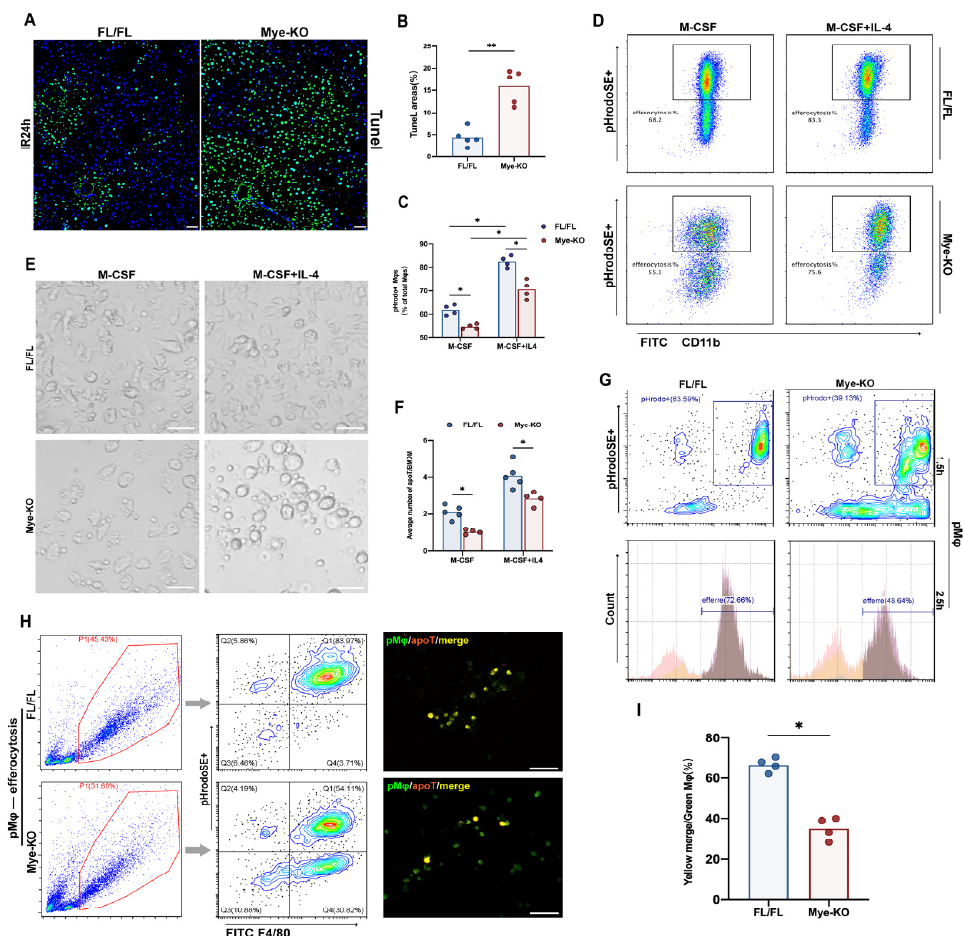
Figure 5. Myeloid Trem2-controlled efferocytosis promotes the resolution of IR inflammation. ( A ) Tunel staining was used to determine the number of apoptotic cells in the IR24h liver of Trem2 FL/FL or Trem2 mKO , scale bars=50 μ m; ( B ) Qualification of Tunel staining ( ** p < 0.01 ) ; ( C , D ) BMDMs of Trem2 FL / FL or Trem2 mKO were co-cultured with dexamethasone-induced thymocytes incubated with pHrodo in the presence or absence of IL4 for 2 h, and then the ratio of pHrodo+SE was detected by flow cytometry (* p < 0.05); ( E , F ) calculate the average number of apoptotic cells phagocytized by each macrophage (* p < 0.05, scale bars = 20 μ m); ( G ) Peritoneal macrophages were isolated 3 days after intraperitoneal injection of zymosan into Trem2 FL/FL or Trem2 mKO mice and then co-cultured with dexamethasone-induced thymocytes incubated with pHrodo for 1.5 h or 2.5 h, and then the efferocytosis efficiency was detected; ( H ) Peritoneal macrophages were isolated 11 days after intraperitoneal injection of zymosan into Trem2 FL/FL or Trem2 mKO mice, and then co-cultured with dexamethasone-induced thymocytes incubated with pHrodo for 1.5 h , scale bars = 50 μ m. ( I ) Then the efferocytosis efficiency was detected (* p < 0.05).